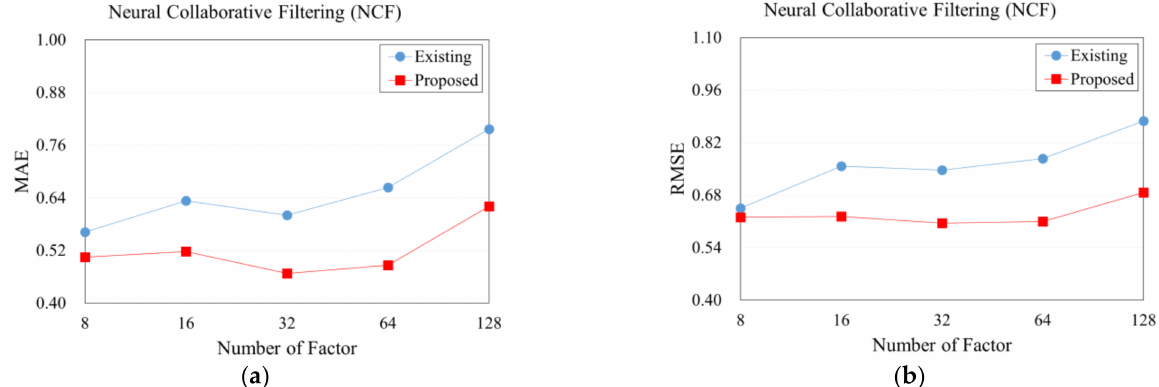
Figure 8. Prediction performance of MAE ( a ) and RMSE ( b ) of NCF model. Table 6. Two samples t-tests between existing and proposed framework in several recommendation method types.